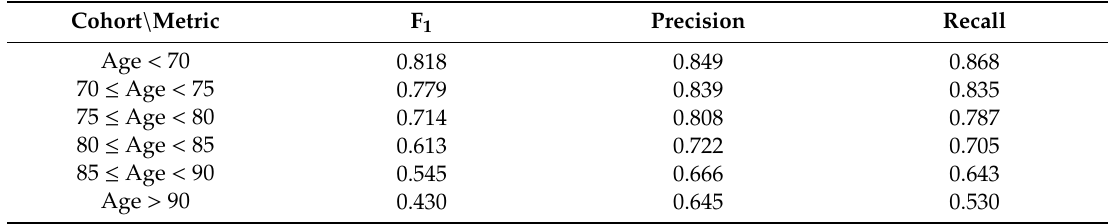
Table 9. The performance metrics of specifics cohorts on the ANN